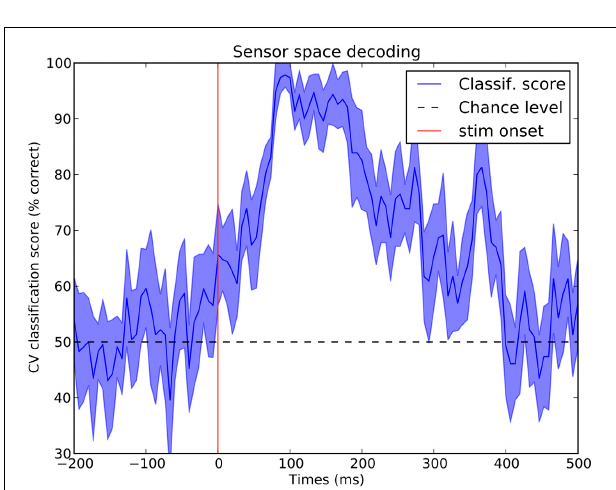
between auditory stimulation and visual stimulation using the sample dataset. The red regions were more active after auditory than after visual stimulation, and vice-versa for blue regions. Image (B) was produced with PySurfer .